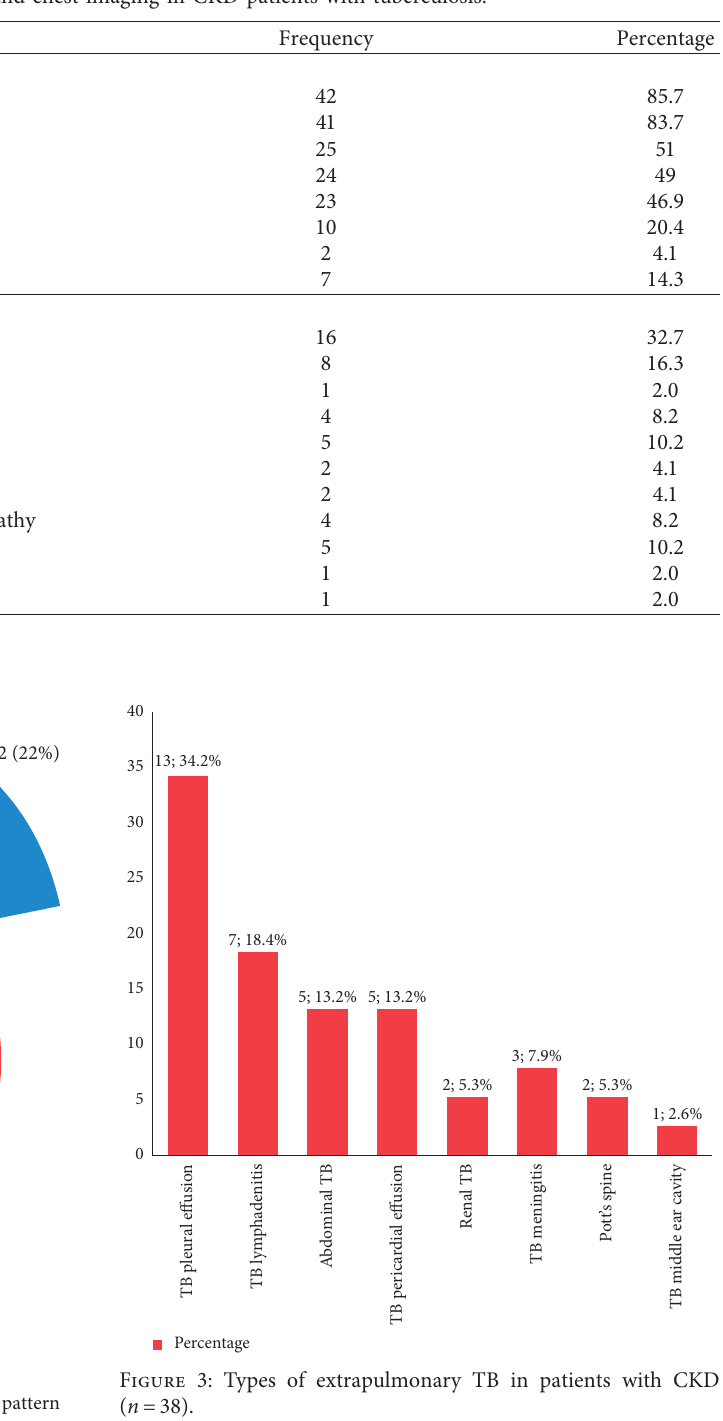
Table 3: Clinical presentation and chest imaging in CKD patients with tuberculosis.